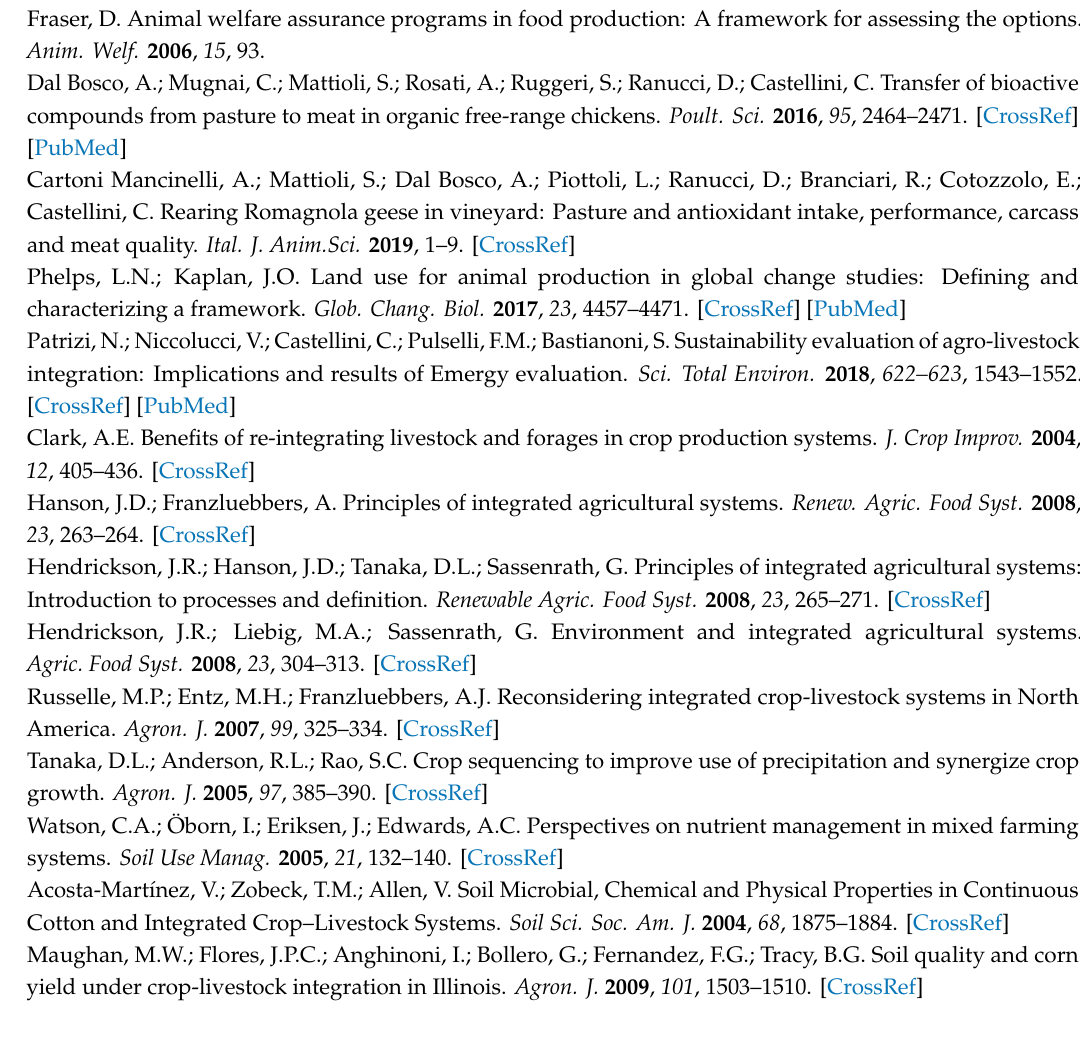
Table S1: Morphological description by Schoeneberger et al. (2012) of the profiles of the vineyard soils with a High (HGD) and Low (LGD) Geese Density, and of the soil of the control vineyard Without Geese (WG), Cannara (PG, central